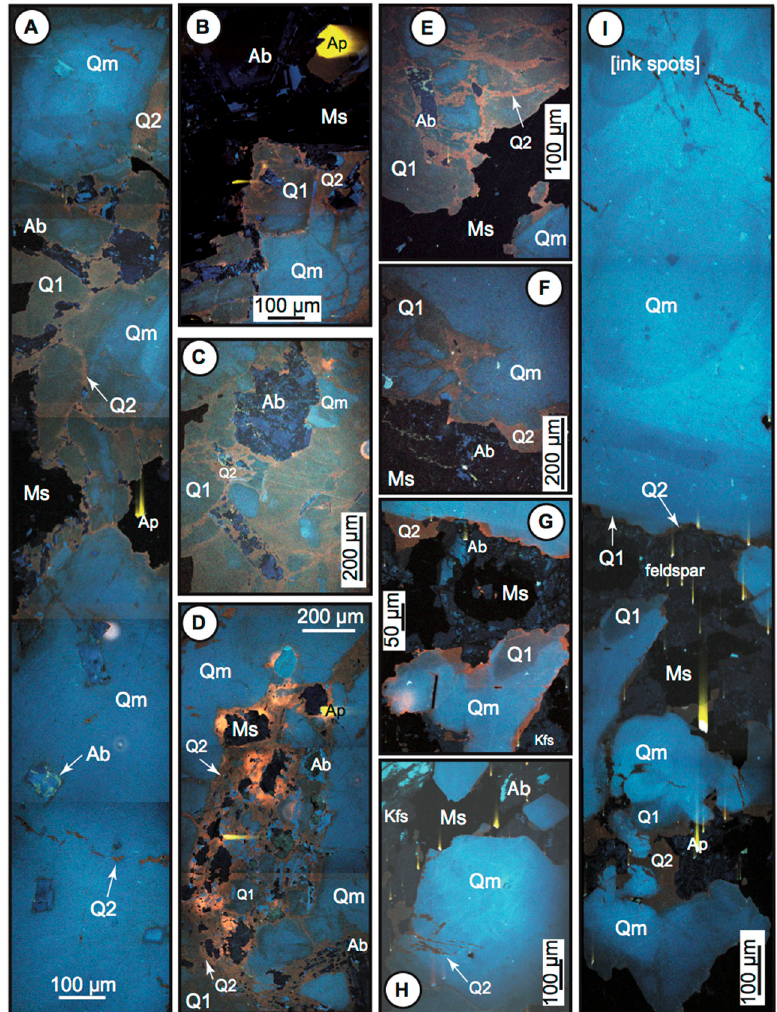
Figure 18. Quartz texture revealed by cathodoluminescence (CL, RBG synthetic images). Three luminescence levels discriminate quartz types: blue luminescent quartz (Qm), brownish luminescent quartz (Q1), reddish luminescent quartz (Q2). ( A – E ) Greisenised granite from the L2 level. ( A ) Profile through the contact between a magmatic quartz phenocryst (bottom) and the surrounding quartz-muscovite-albite matrix (sample PNQ-13a). The matrix is constituted of brownish Q1 quartz, crisscrossed by Q2 veinlets. ( B ) Quartz-albite-muscovite of the greisen (sample PNQ-13a). Blue Qm is surrounded by brownish Q1, and both are crisscrossed by Q2. The latter is fringing the muscovite. ( C ) Quartz-albite-muscovite matrix of the greisen (sample PNQ-19a). Cores of blue Qm are isolated within a Q1 matrix, with crisscrossing Q2 veinlets. Albite is corroded and invaded by both Q1 and Q2. ( D ) Quartz-albite-muscovite matrix (Q1 and Q2) in contact with blue Qm (sample PNQ-19a). ( E ) Quartz-albite matrix and muscovite lath (sample PNQ-19a). Q1 surrounds Qm cores, and Q2 veinlets crisscross both. ( F ) quartz phenocryst border in a granite G2 from the SCB2 drill hole (sample PAN16-8). Q1 and Q2 dilacerate the blue magmatic quartz Qm. ( G – I ) porphyritic granite G1 from the SCB2 drill hole. ( G ) Quartz-feldspar-muscovite matrix of the porphyritic granite (sample PAN16-7a). Quartz is mostly formed by blue luminescent Qm, associated with minor Q1, and fringed by reddish luminescent Q2. ( H ) Zoned magmatic quartz grain included in a perthitic K-feldspar megacryst (sample PAN16-5b). Note the Q2 expansions into the K-feldspar and as microcracks within the magmatic quartz. ( I ) Profile from a zoned quartz phenocryst to the quartz-muscovite-albite-Kfs matrix (sample PAN16-7a). The great majority of the quartz consists of blue (magmatic) Qm, with tiny and discontinuous fringes of Q1 and Q2.